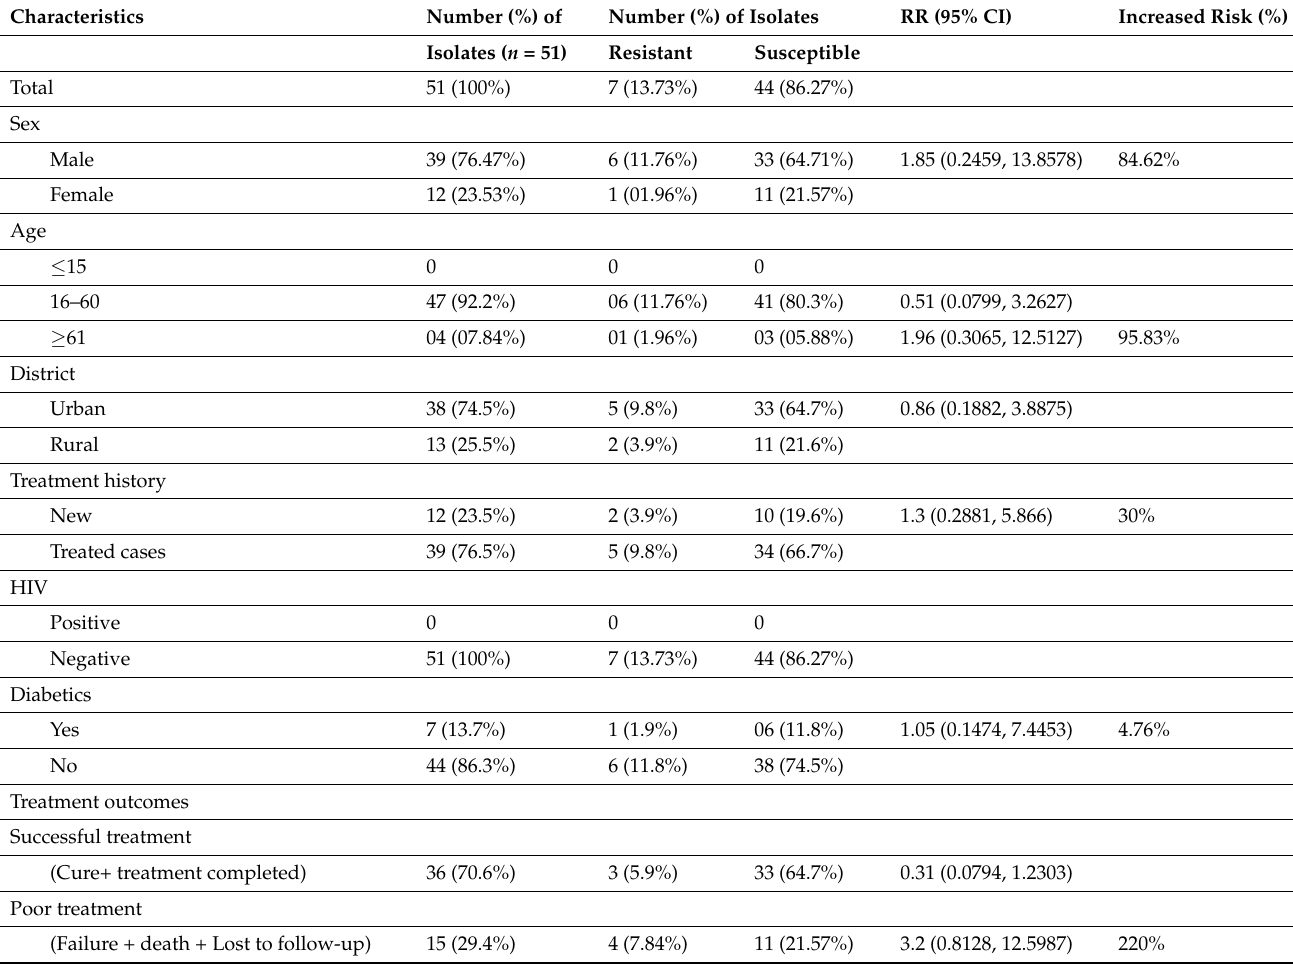
Table 3. Multivariate analysis to evaluate the risk factors of pre-XDR among 51 MDR